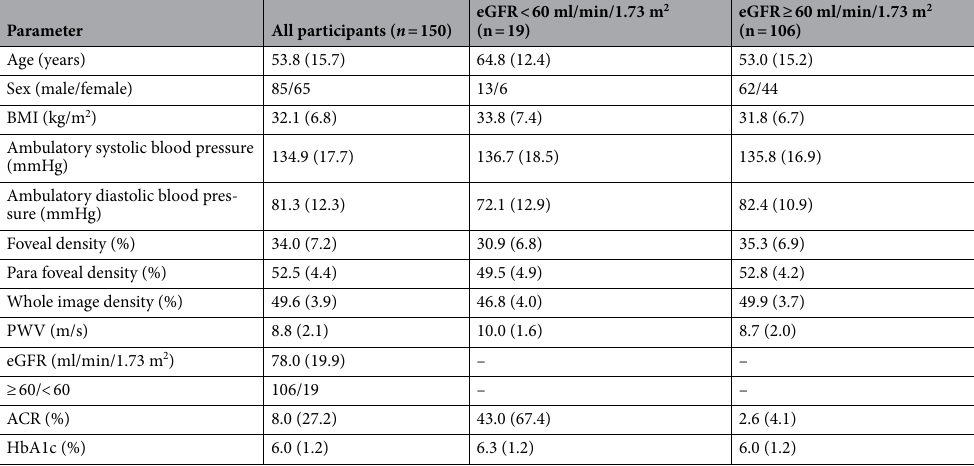
Table 1. Continuous clinical characteristics of the analyzed patient cohort. Data are given as mean (SD). BMI, body mass index; blood pressure data from ambulatory 24 h analysis; PWV, carotid-femoral pulse wave velocity; eGFR, estimated glomerular filtration rate; ACR, albumin-to-creatinine ratio; HbA1c, glycated hemoglobin.